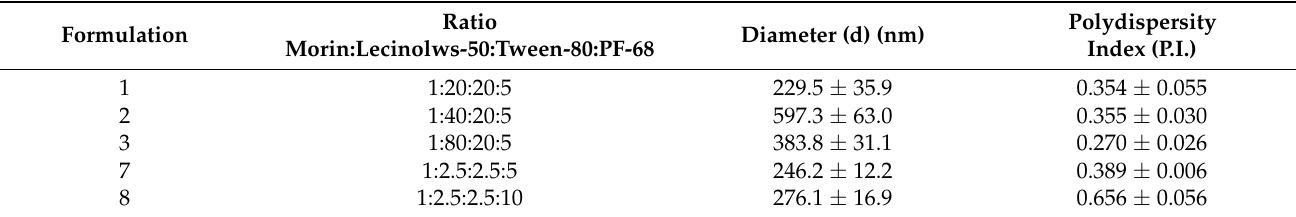
Table 5. Diameter and polydispersity index of liposomal morin with different